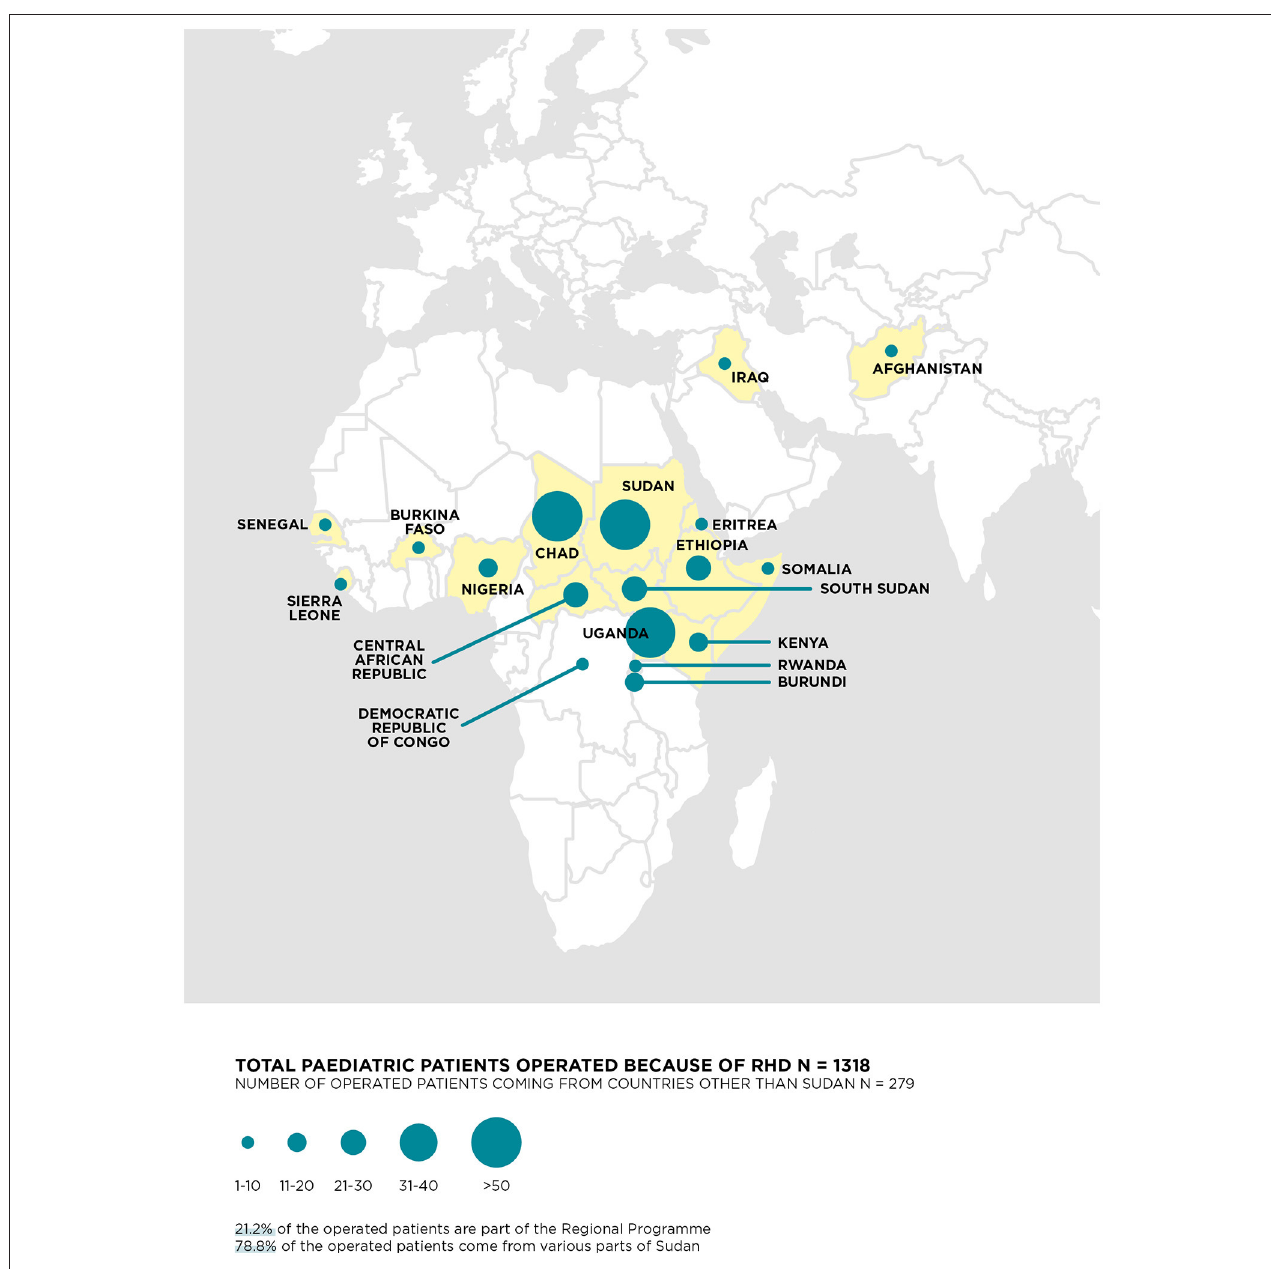
FIGURE 1 | Countries of origin of the 1,318 RHD